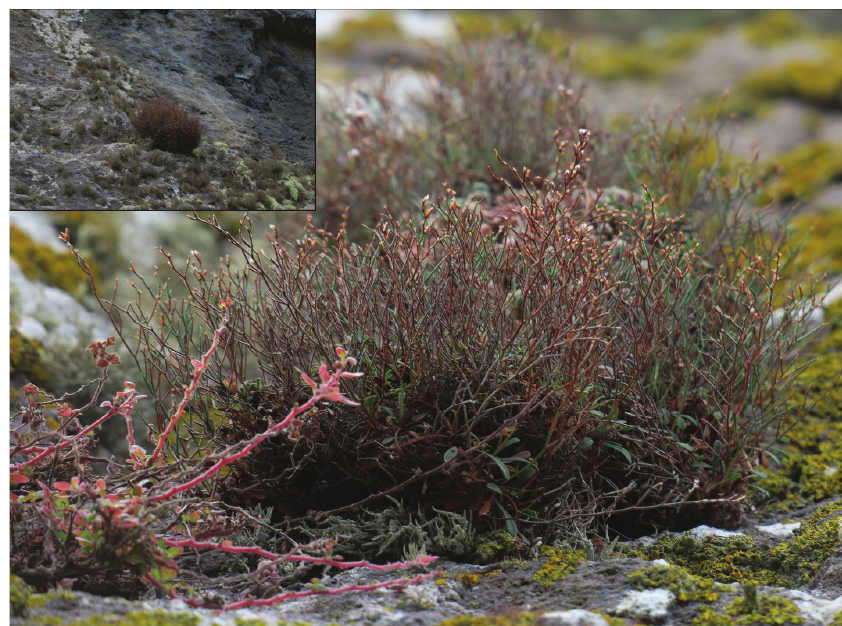
Figure 1. Limonium parvifolium (Tineo) Pignatti on the volcanic rock cliff at Gelfiser (Pantelleria, Sic- ily). Photograph by S. Cambria.